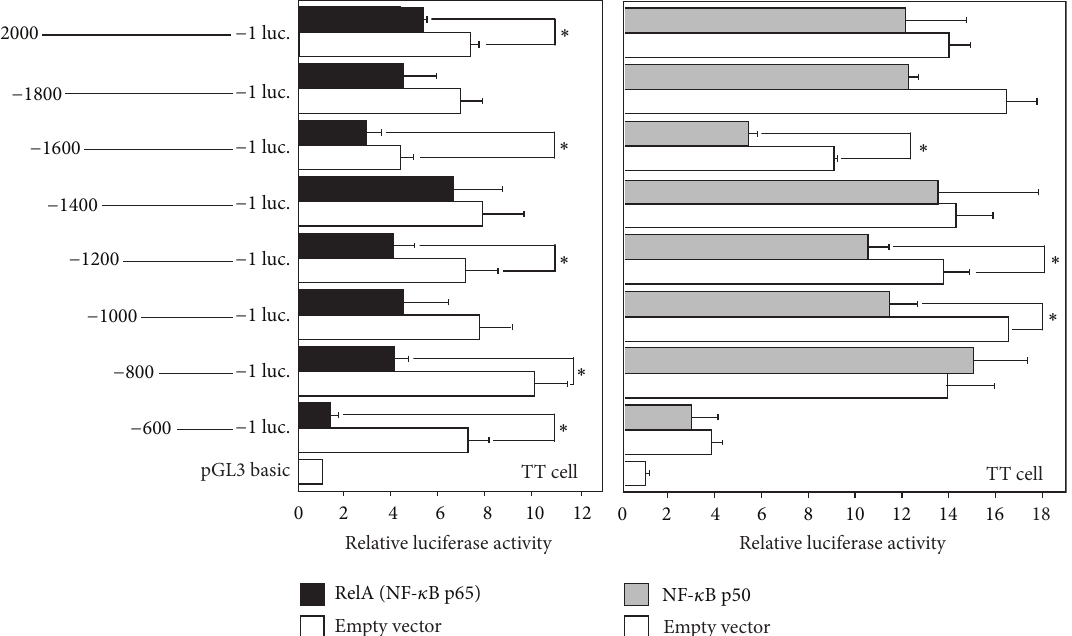
Figure 6: Ghrelin promoter activity by RelA (NF- 𝜅 B (p65)) and NF- 𝜅 B (p50). Schematic diagram representing deletion of the human ghrelin promoter introduced into the upstream of the firefly luciferase gene. Each construct ( − 2000-, − 1800-, − 1600-, − 1400-, − 1200-, − 1000-, − 800-, and − 600-Ghrelin-Luc) was transiently cotransfected with pRL-CMV together with each transcription factor vector or an empty vector. Promoter activity was normalized to Renilla luciferase activity. The data represent the mean ± SE for triplicate samples. Asterisks indicate the differences between each group ( 𝑃 < 0.05